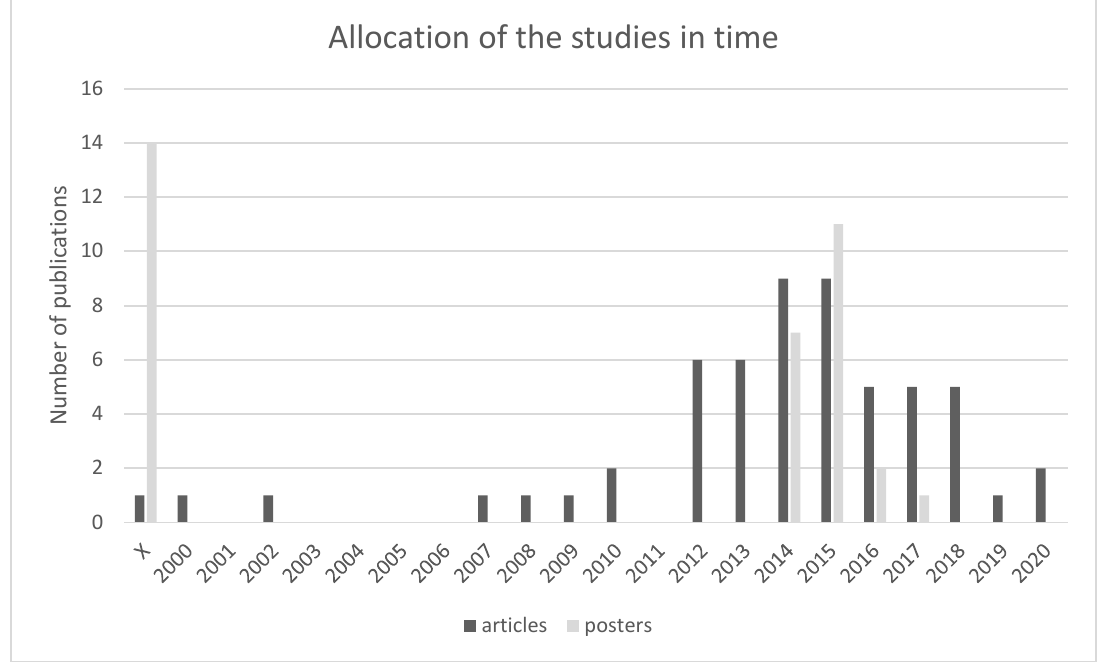
Figure 5. Shows the allocation of publications in time which suggests a significant increase of such publications since 2012. In total, 60 articles and 39 posters were included in the research. Most articles were published between 2014 and 2015 and most posters were published in 2015 [1–99].